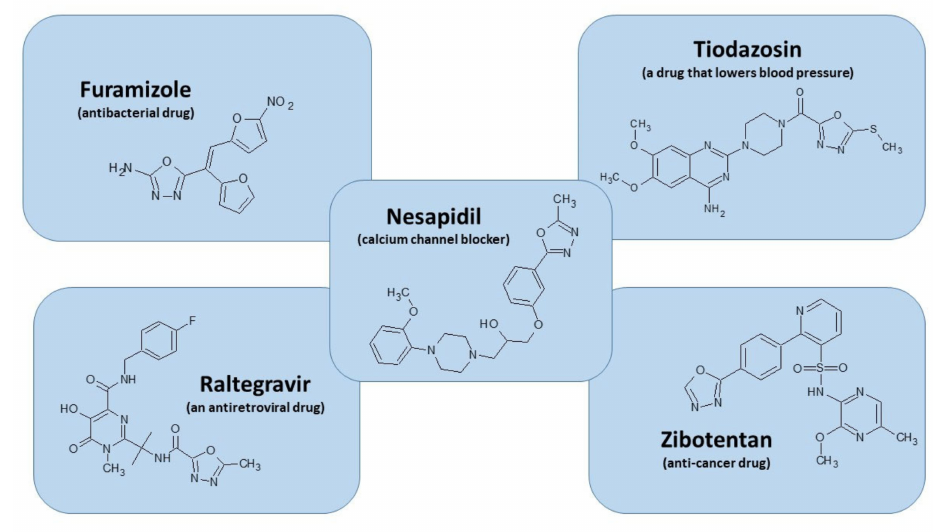
Figure 1. Commonly used medicines bearing 1,3,4-oxadiazole